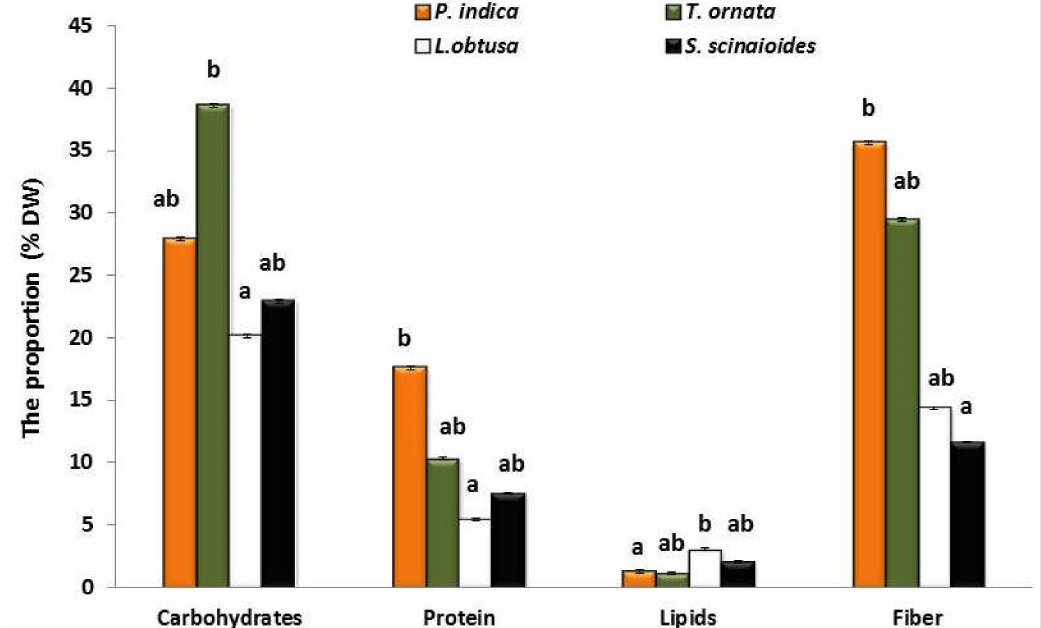
Figure 5. Biochemical composition (% of DW) of the four studied seaweeds. Values are the mean of three replicates ± standard deviations (SD). Different letters refer to significant differences between species ( p <